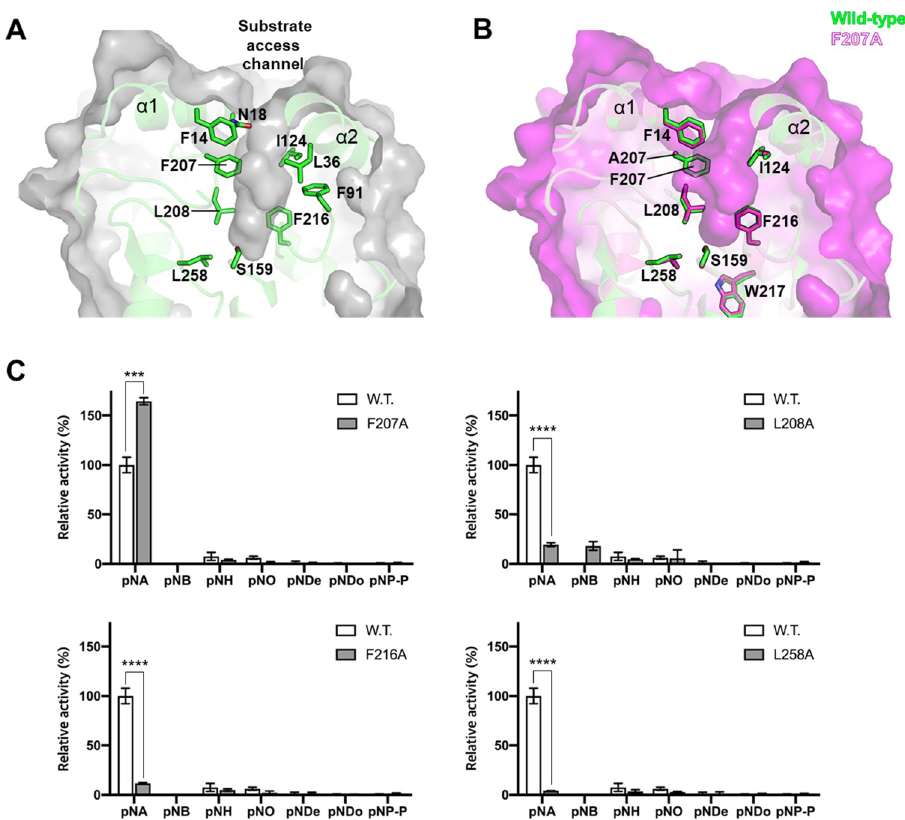
Fig 3. Characterization of the active site of Lg EstI. (A) Representation of the Lg EstI substrate access channel. Illustrated and surface views of the enzyme. (B) Superimposed structure of Lg EstI wild-type (green) and mutant F207A (magenta). Residues around the substrate access channel are depicted with sticks. (C) Comparative activity of the wild- type Lg EstI and mutant enzymes with various substrates. The activity value obtained with wild-type Lg EstI was defined as 100%. All data are presented as mean ± standard deviation (s.d.) (n = 3). The activity of Lg EstI wild-type against p NA was used as the reference and percentage levels to the reference are shown. Statistical significance ( p values) was calculated using a t -test. P values were indicated by ��� (p < 0.001), and ���� (p < 0.0001). Statistical analyses were performed in GraphPad Prism software v.8.3.0.